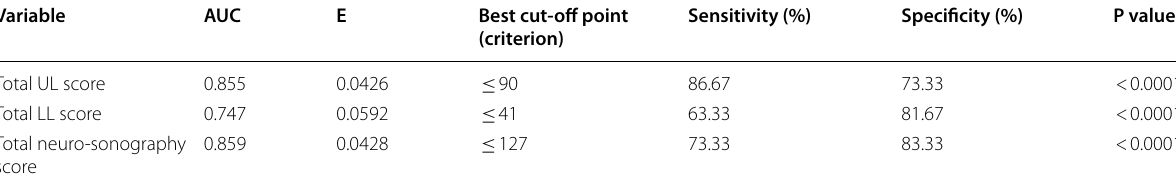
ROC receiver operating characteristic, AUC area under curve, SE standard error